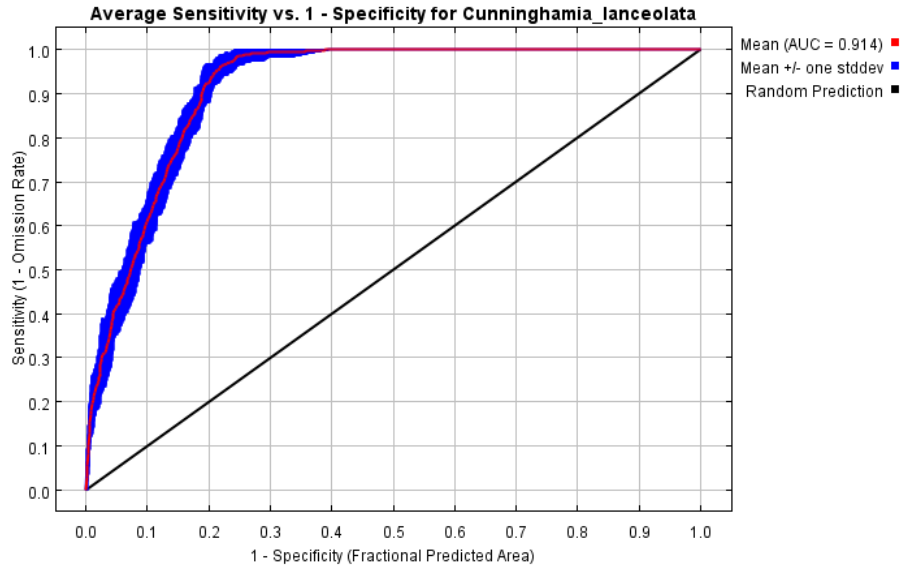
Figure 2. Reliability test of the distribution model created for C. lanceolata.